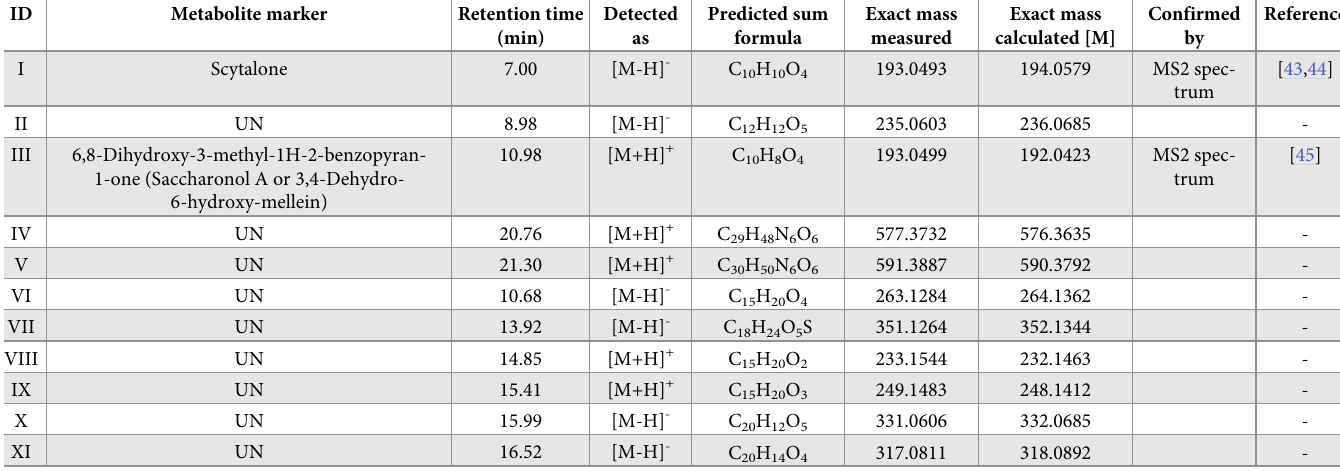
Table 1. Differentially expressed metabolites of V . dahliae detected by LC/MS.